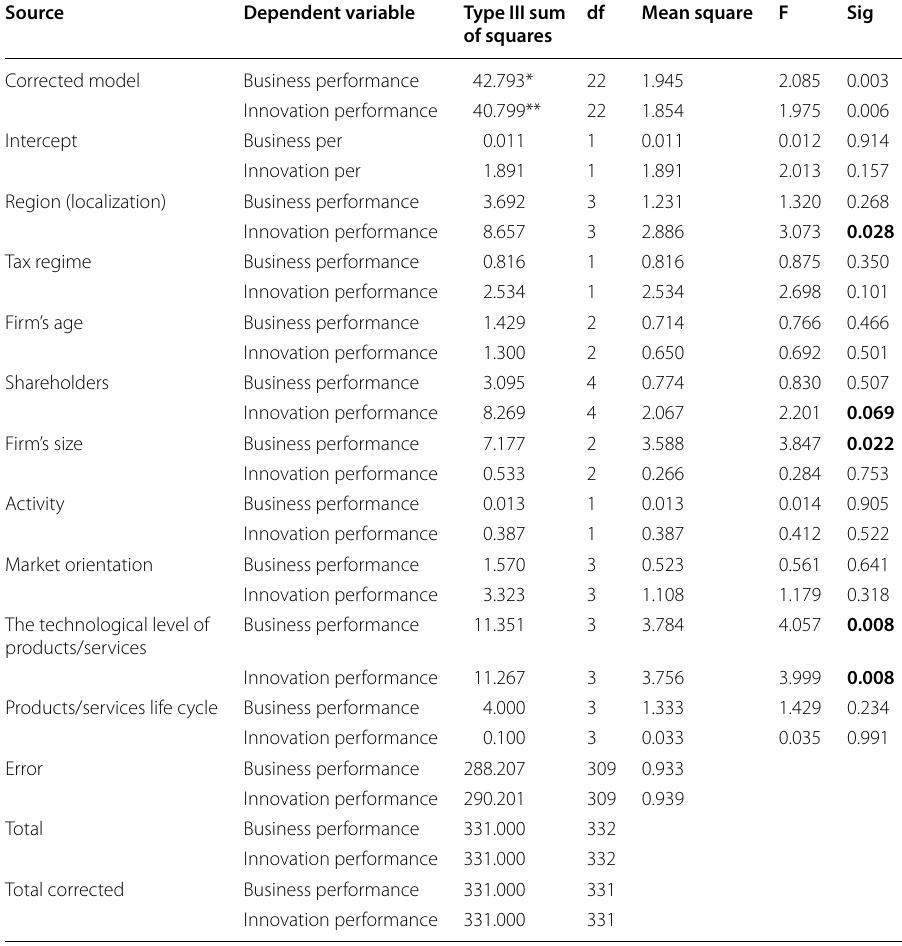
Table 5 Tests of between‑subject effects of the MANOVA